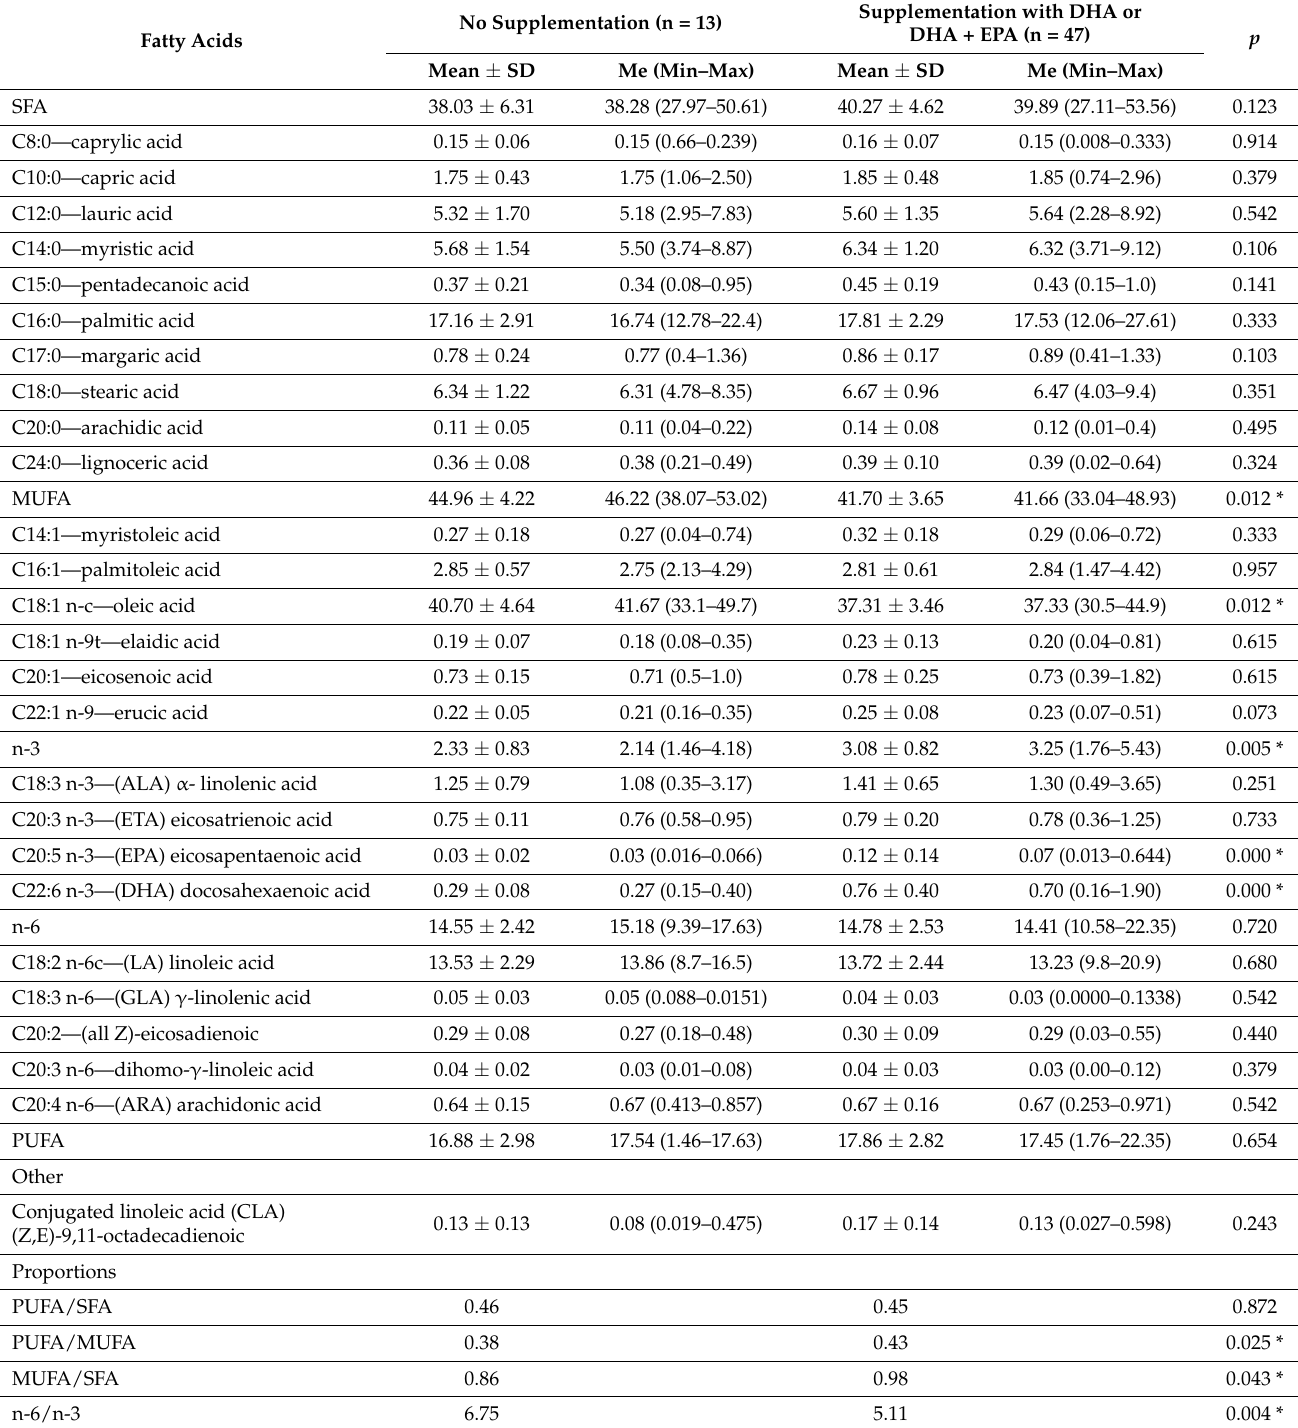
Table 5 shows the levels of fatty acids in breast milk depending on postpartum supplemen- tation with DHA or DHA + EPA. Women taking dietary supplements had significantly higher levels of DHA (0.76% vs. 0.29%) and EPA (0.12% and 0.03%). It was also noted that women not using supplementation had significantly higher levels of oleic acid (40.7% vs. 37.31%; p = 0.012). Table 5. Fatty acid content of breast milk (g/100 g of total FA) depending on supplementation with DHA or DHA +